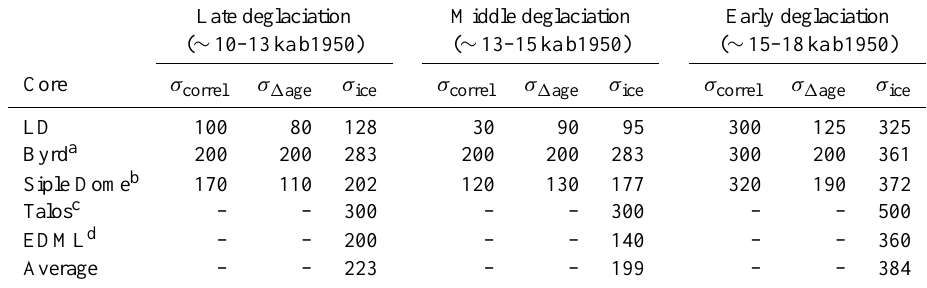
Table 3. Dating uncertainties in the individual records used in the Antarctic composite during the deglaciation (Sect. 2.4)